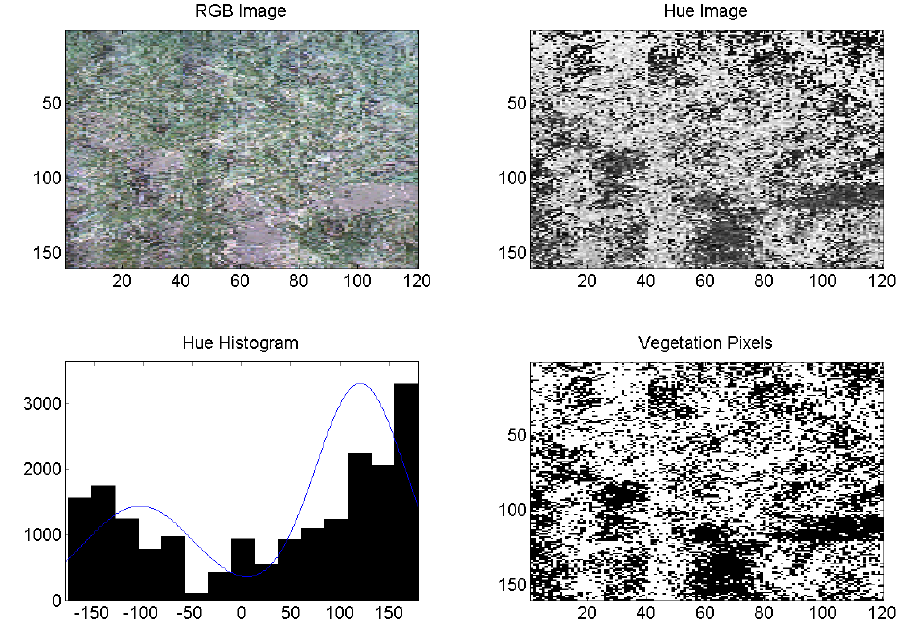
Figure 10. Example of wireless computer vision image analysis for wheat, DOY 88, 2013, diseased, 100%. Axes on images are in